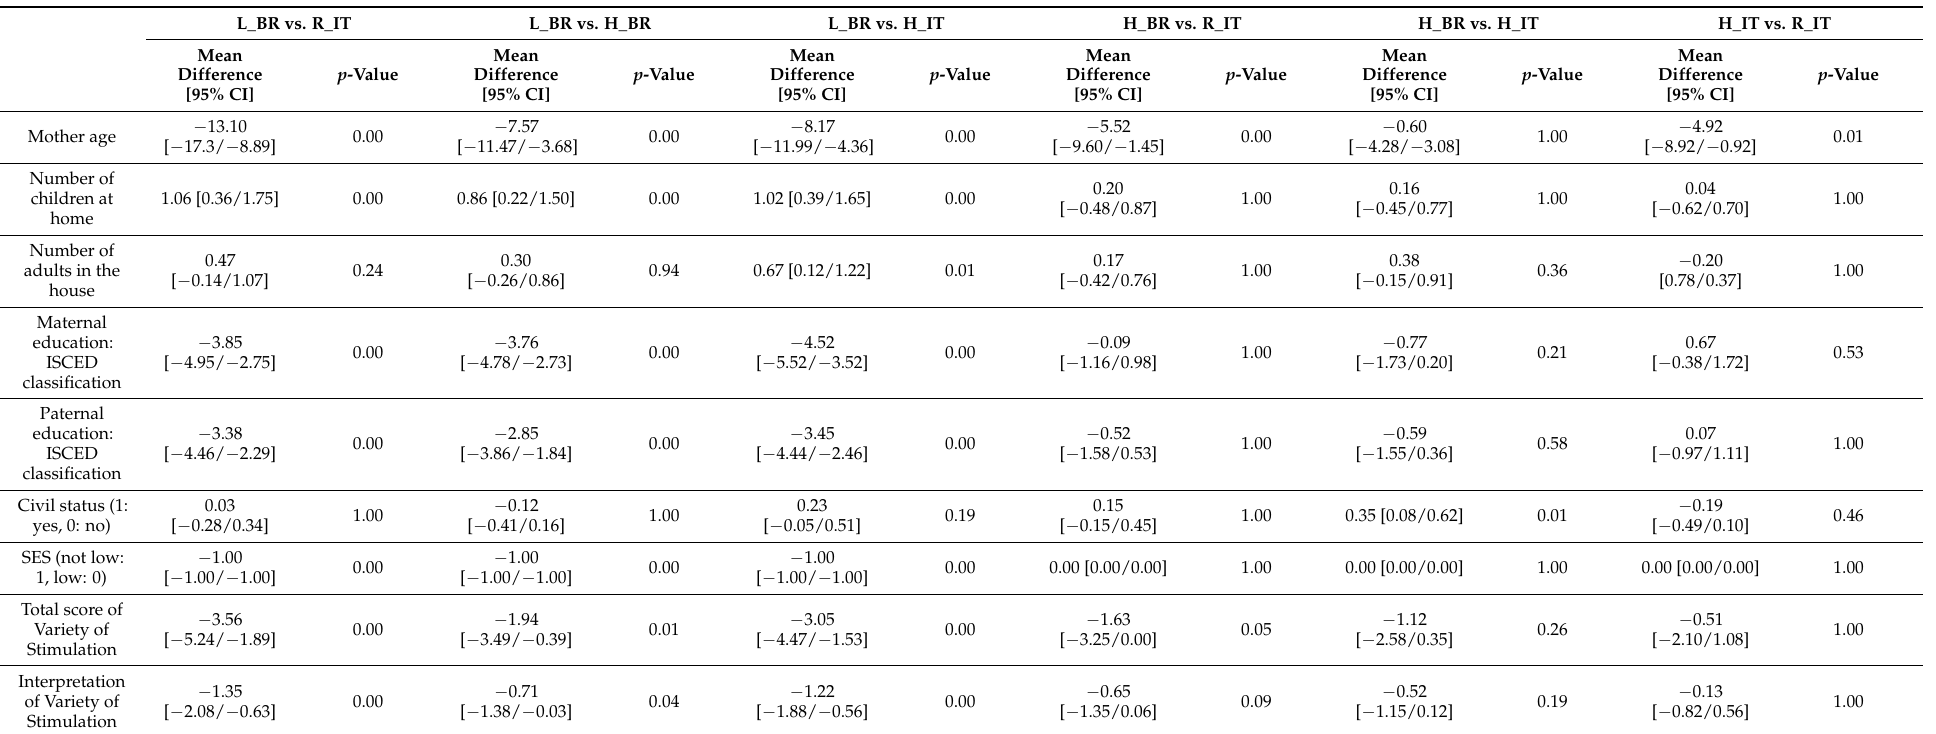
Table 3. Post hoc analyses in order to compare the